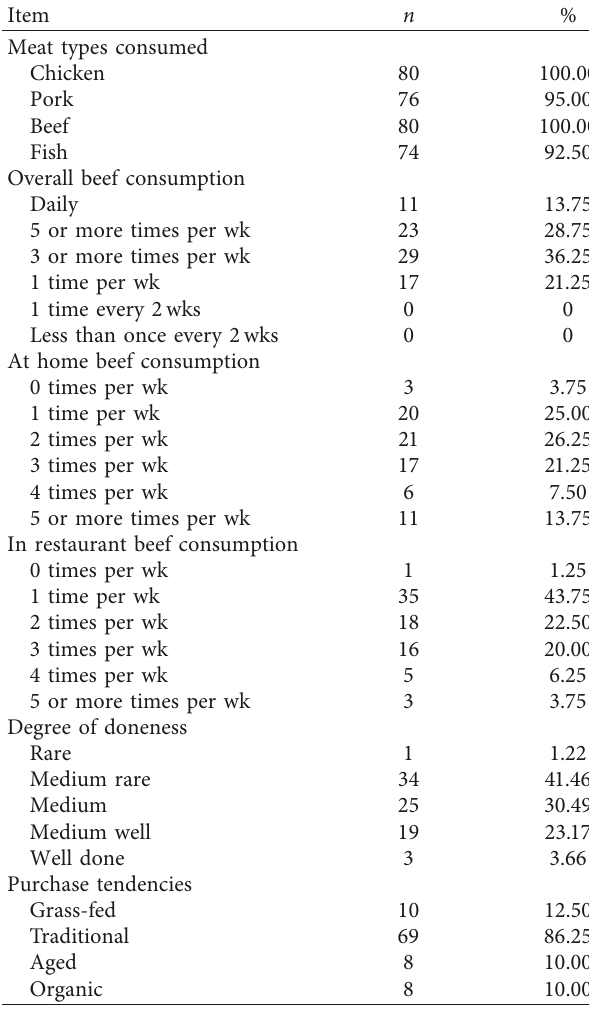
Table 2: Consumer panelists’ consumption